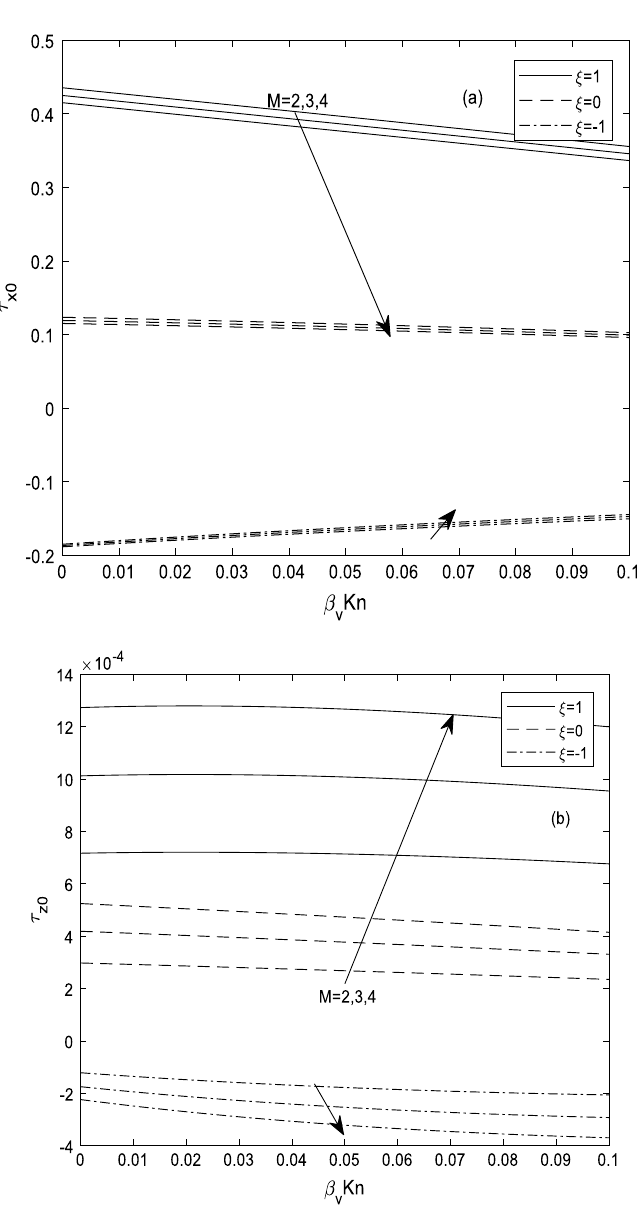
Fig. 8 a Hartmann number ( M ) on the main flow and induced skin friction profiles at y = 0 , for S = 0.5,ln = 1.667, β h = 0.5, β i = 3.0 and Pr = 0.71 . b Hartmann number ( M ) on the main flow and induced skin friction profiles at y = 0 , for S = 0.5,ln = 1.667, β h = 0.5, β i = 3.0 and Pr =